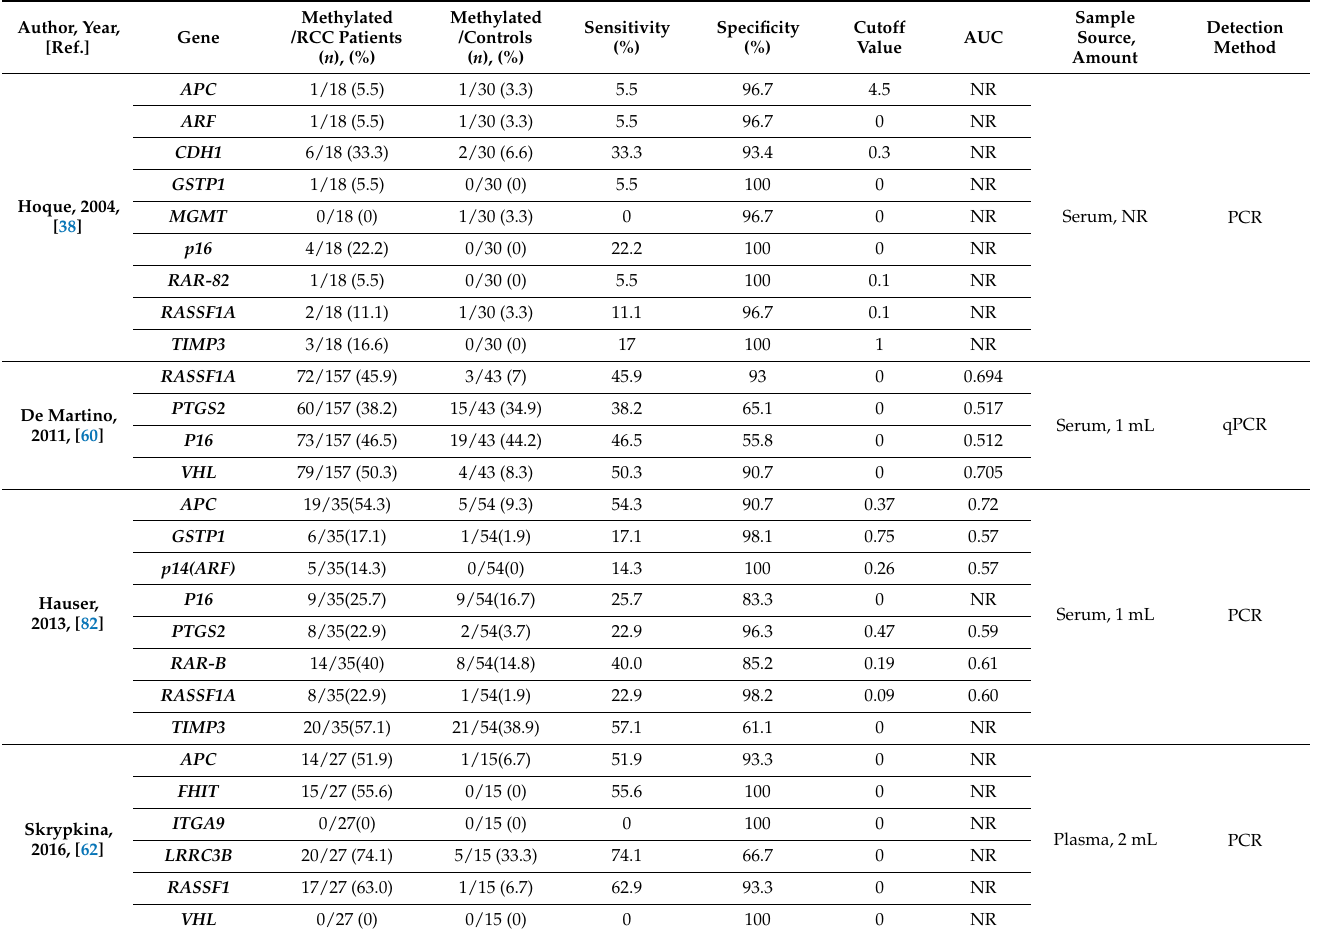
Table 2. Diagnostic data of methylation analysis of circulating cell-free DNA (cfDNA) in patients with renal cell carcinoma (RCC). APC, adenomatosis-polyposis-coli gene; ARF, auxin response factors; CDH1, cadherin-1 gene; cfDNA, cell-free DNA; FHIT, fragile histidine triad gene; GSTP1, glutathione- S-Transferase Pi 1 gene; ITGA9, integrin subunit alpha 9 gene; LRRC3B, leucine rich repeat containing 3B gene; MGMT, O-6-methylguanine-DNA methyltransferase gene; NR, not reported; p16, cyclin- dependent kinase inhibitor 2A; PCR, Polymerase chain reaction; PTGS2,